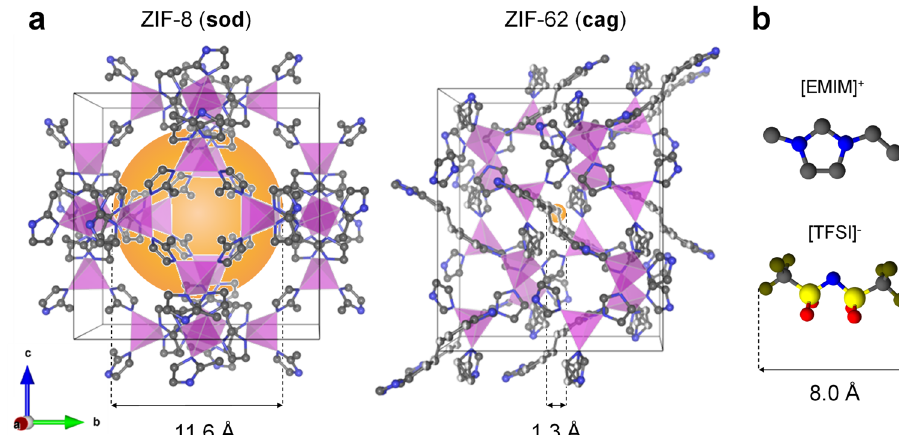
Fig. 1 Crystal structure of ZIF-8 and ZIF-62 and molecular structure of [EMIM][TFSI] used in IL@ZIF-8 composite. a Crystal structures and pore diameters of ZIF-8 and ZIF-62. The orange spheres in the crystal structures are drawn to mark the free space inside the cages 26 . Crystallographic data of ZIF-8 and ZIF-62 are taken from literature 24,25 . b Molecular structure of [EMIM][TFSI]. Color codes: Zn – purple tetrahedra, N – blue, C – gray, S – yellow, O – red, F – olive. H – omitted for